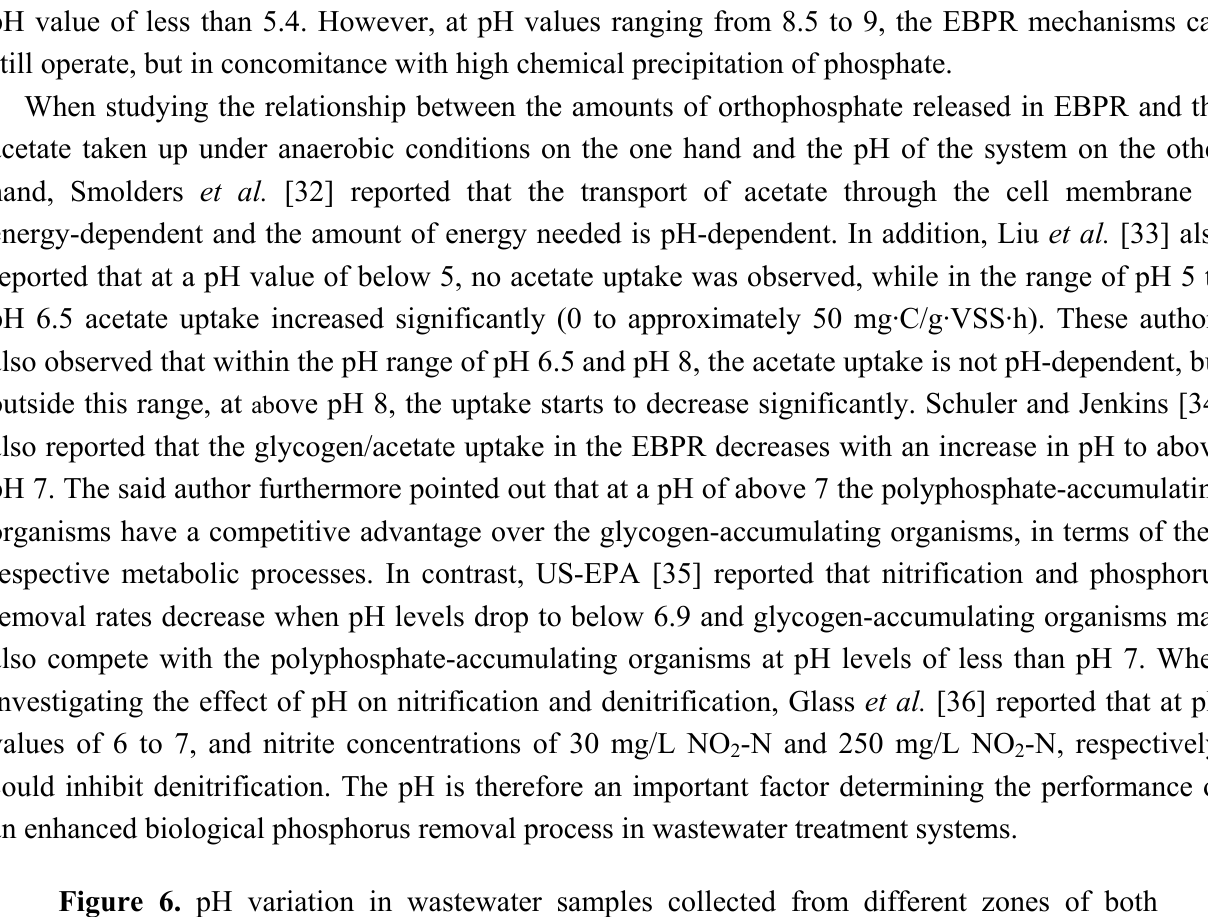
Figure 6. pH variation in wastewater samples collected from different zones of both Unit-3 and Unit-5 of the Northern Wastewater Treatment